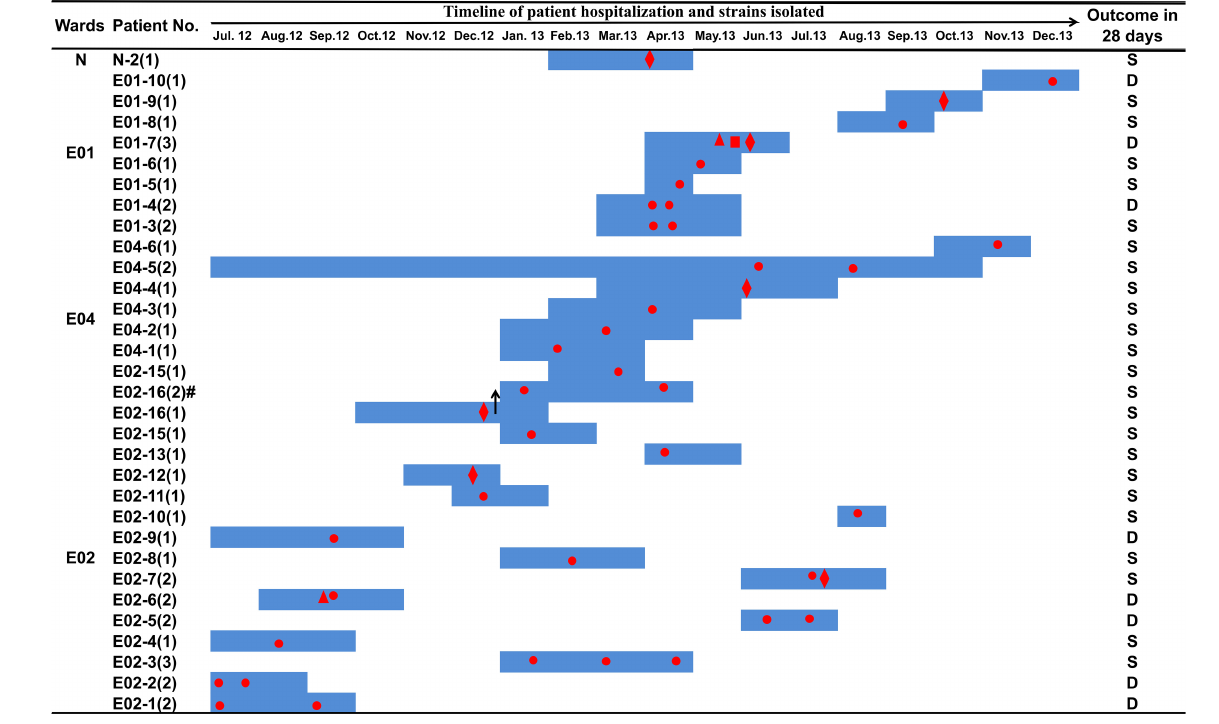
Frontiers in Microbiology |